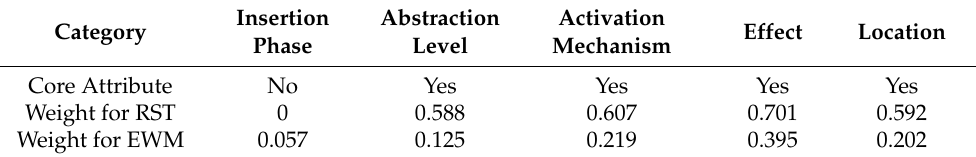
Table 2. Weight Analysis and Core Attribute